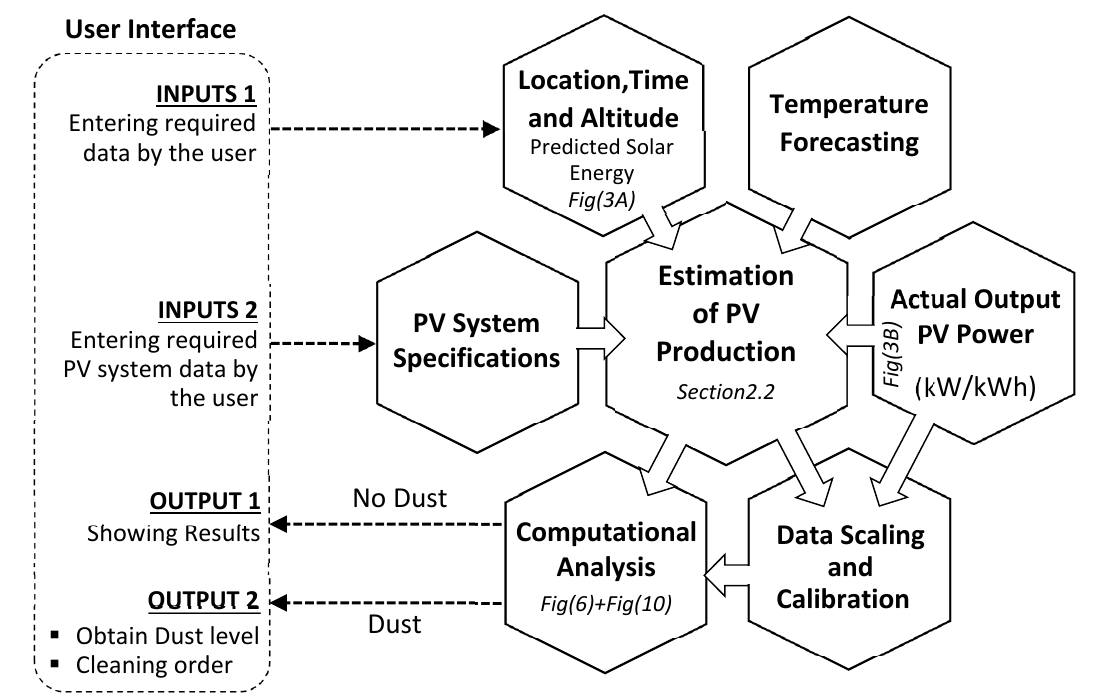
Figure 9. Methodology of the proposed intelligent dust detection unit (expert system).